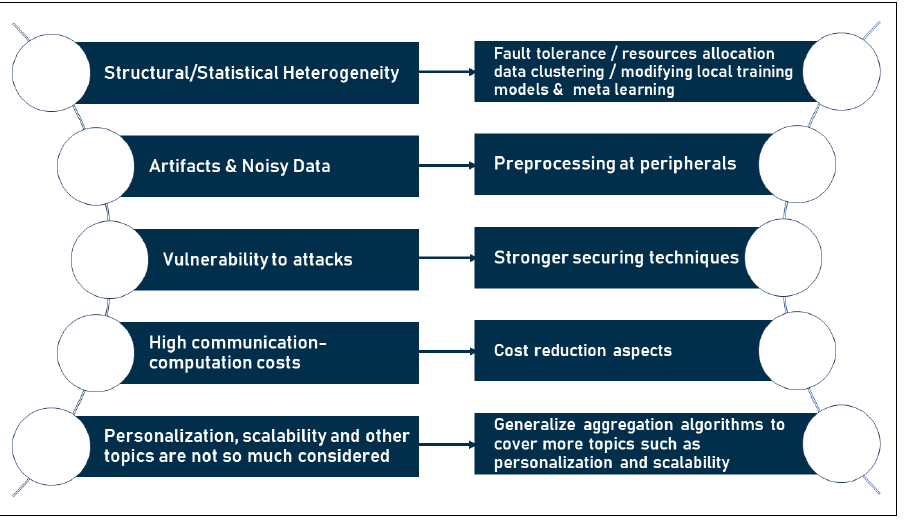
Figure 10. Challenges–future solutions